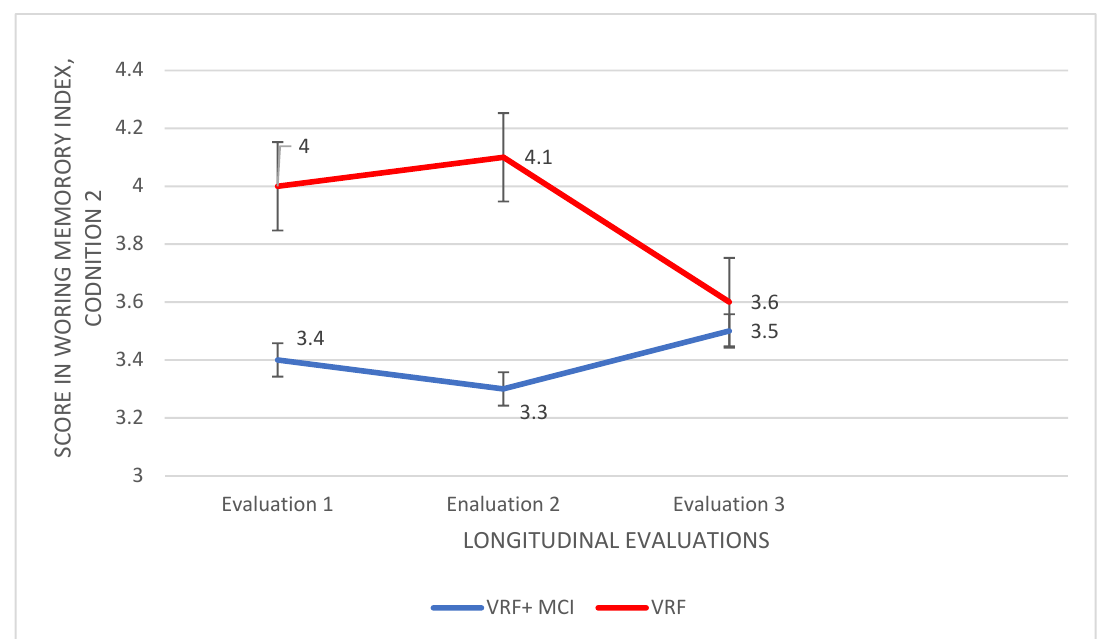
Figure 5. Performance of adults with VRF and adults with VRF + MCI in the Backward condition (working memory) of Digit Span Test.